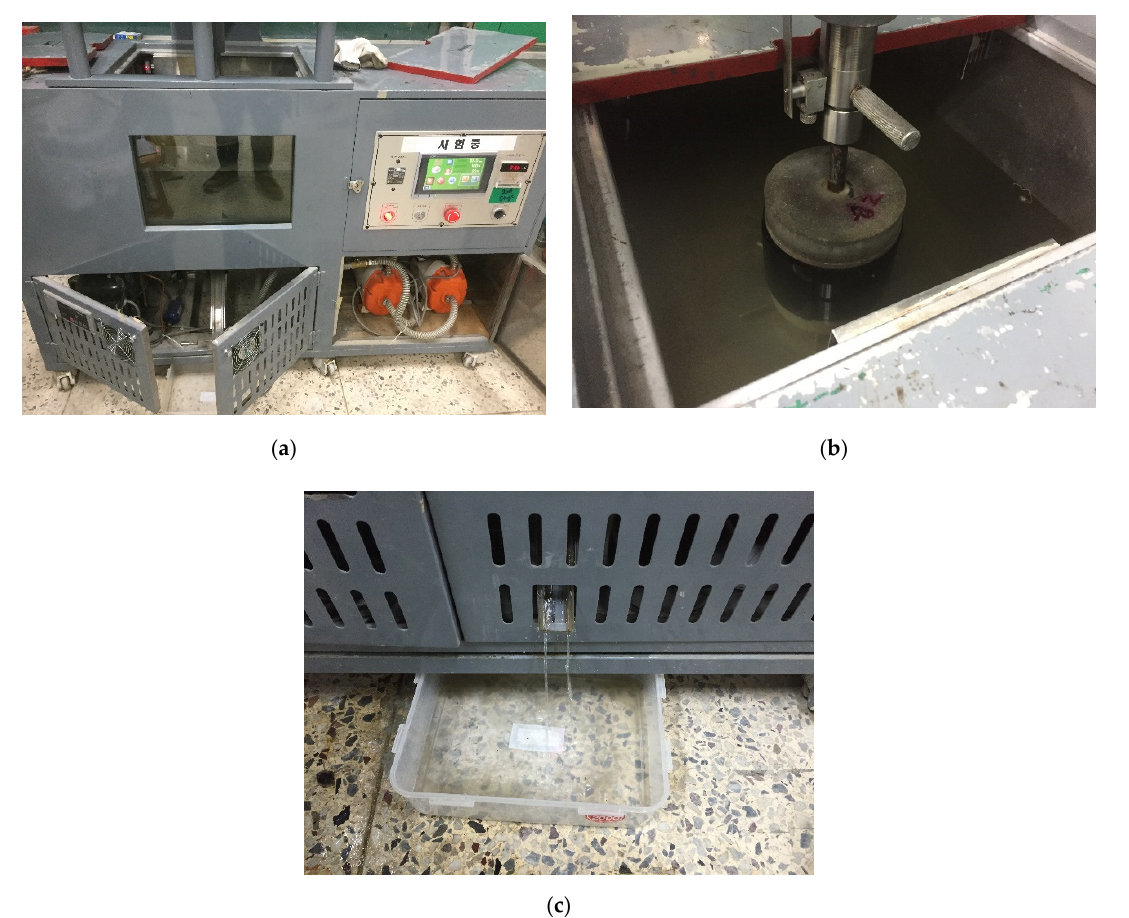
Figure 10. Testing apparatus illustrated. ( a ) Overview of the joint opening simulation water chamber; ( b ) specimen installed in the joint opening simulation water chamber; ( c ) leakage outlet for alerting leakage occurrence during testing.